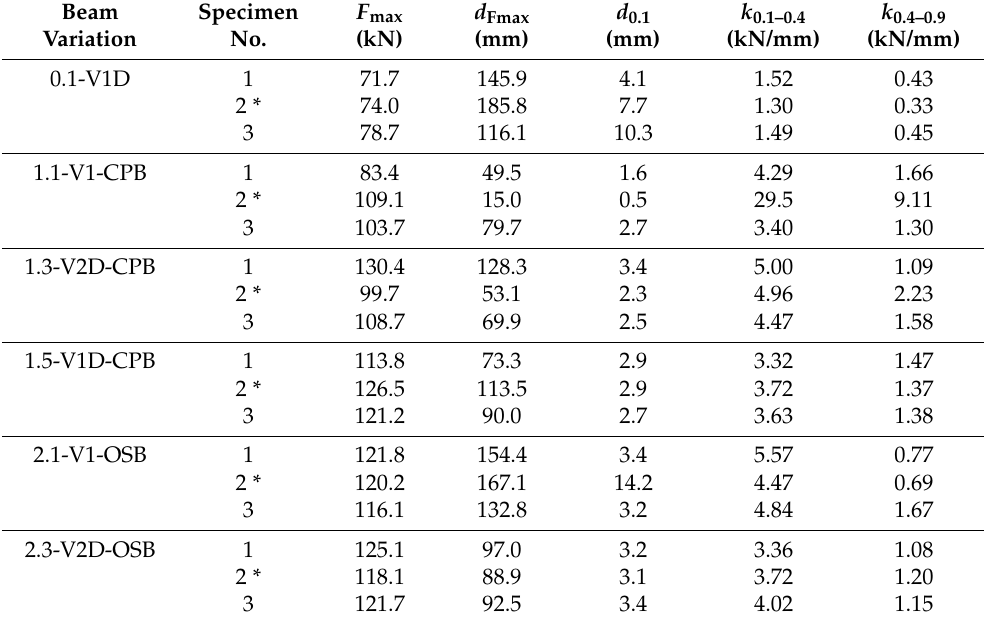
* Tests with extended loading protocol (loading protocol “b” with 2nd loading phase).